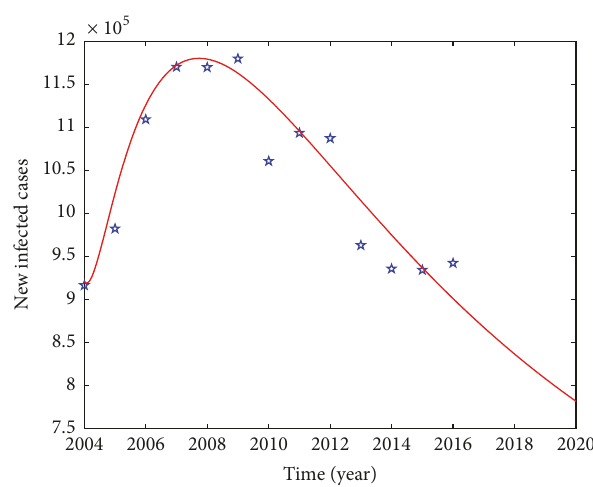
Figure 4: Data fitting for the annually reported cases (pentagram) from 2004 to 2016 by model (1) (solid